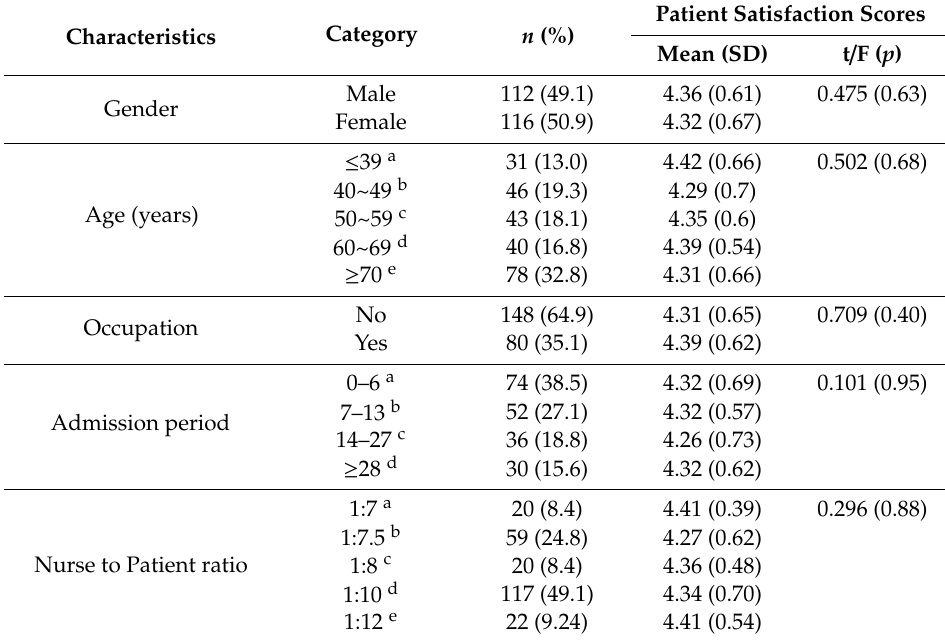
Table 6. Di ff erences of Patient Satisfaction Scores according to the General Characteristics of Comprehensive Nursing Care Service Ward ( n =